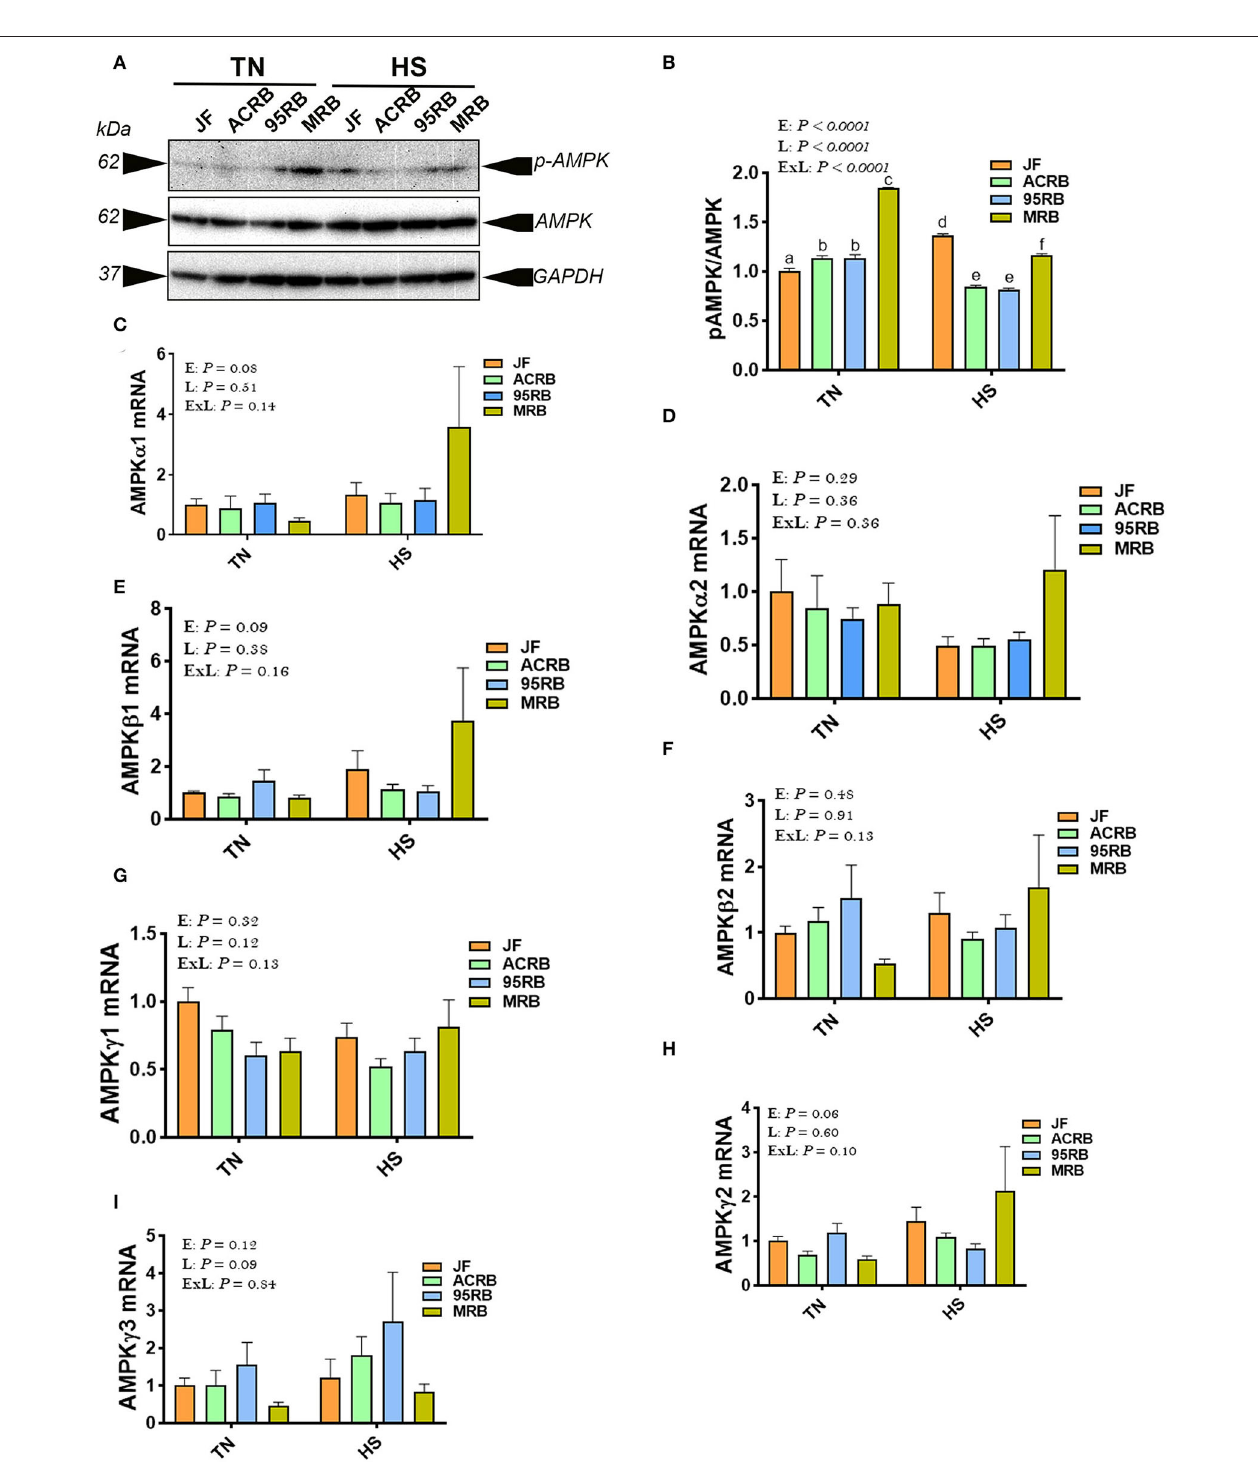
FIGURE 3 | Effect of HS on hypothalamic expression of AMPK pathway in three modern broilers and their ancestor JF. Protein and RNA were extracted from hypothalamic tissues and analyzed by western blot (A,B) and qPCR (C–I) , respectively. Gene expression was determined by qPCR using 2 − 11 CT method and data are mean ± SEM ( n = 6/group). Protein expression was presented as ratio of p-AMPK Thr172 /pan AMPK (A,B) . Protein was analyzed via AlphaVIew software and is expressed as mean ± SEM ( n = 3/group) with one representative blot shown (A) . Different letters indicate significant difference at P < 0.05. 95RAN, 1995 random bred; ACRB, Athens Canadian Random Bred; AMPK, AMP-activated protein kinase; E, environment; ExL, interaction between E and L; HS, heat stress (36 ◦ C); JF, jungle fowl; L, line; MRB, modern random bred; TN, thermoneutral (25 ◦ C).